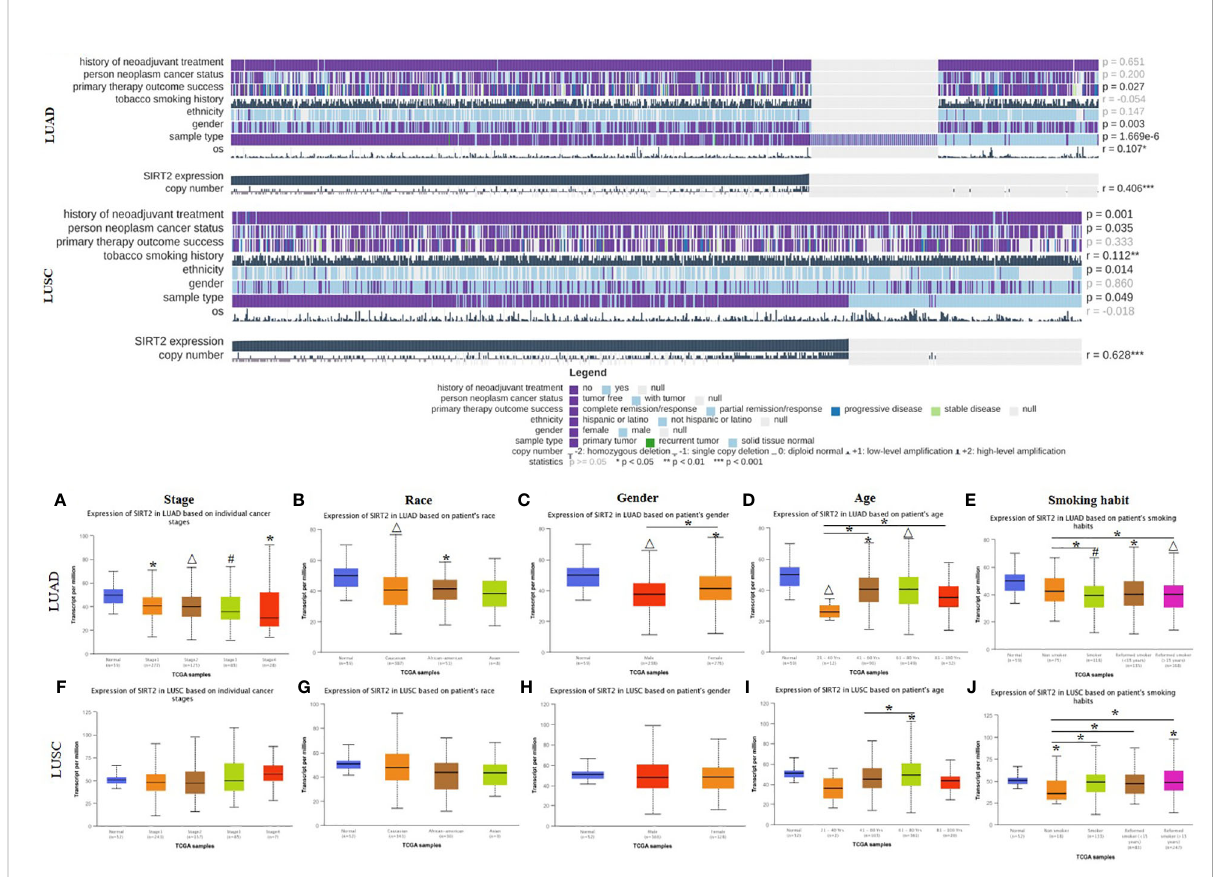
FIGURE 2 TCGA data visualization of the SIRT2 affects on clinicopathological parameters in LUAD and LUSC cohorts. SIRT2 expression levels in fl uence the clinicopathological parameters in LUAD and LUSC cohorts using MEXPRESS (upper), data were reordered by the expression of SIRT2. Expression levels of SIRT2 i mpacts the individual cancer stages (A, F) , patient ’ s race (B, G) , patient ’ s gender (C, H) , patient ’ s age (D, I) , patient ’ s smoking habit (E, J) in LUAD and LUSC cohorts using UALCAN (lower). * P ≤ 0.05, # P ≤ 0.001, △ P ≤